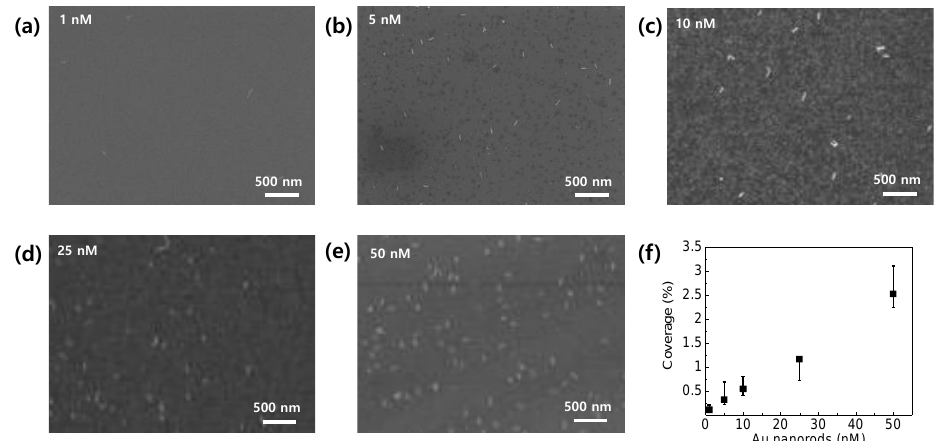
Figure 2. SEM image of 2D PtSe 2 surface coated by ( a ) 1, ( b ) 5, ( c ) 10, ( d ) 25, and ( e ) 50 nM Au nanorods. ( f ) Relationship between the concentration of Au nanorod solution and coverage.